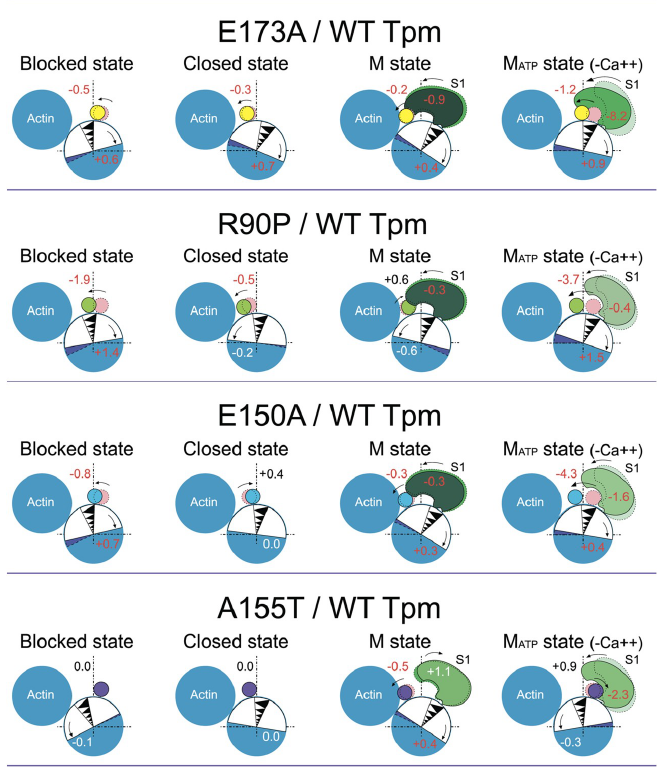
Figure 7. Schematic representation of rearrangements of Tpm, actin monomers and S1 induced by the Tpm mutations E173A, R90P, E150A, and A155T in different structural–functional states of thin filament. All the changes are depicted in comparison with the WT Tpm (dotted lines). The composition of the fiber: actin–Tpm–TN at low Ca 2+ in Blocked state; actin–Tpm–TN at high Ca 2+ in Closed state; S1 bound strongly to actin-Tpm–TN at high Ca 2+ in M–state; S1 bound weakly to actin–Tpm–TN at low Ca 2+ in M ATP -state. TN is not shown for simplicity. Tpm is shown in different colors depending on the mutation; strongly and weakly bound S1 is shown in various shades of green, depending on strength of its binding to F-actin. The direction of the presumed actin monomer rotation, axial shift of Tpm strands and translocation of S1 induced by the mutation are shown by arrows. The digits indicate changes in the Φ E values (in degrees) for the fluorescent probe attached to each protein (see Section